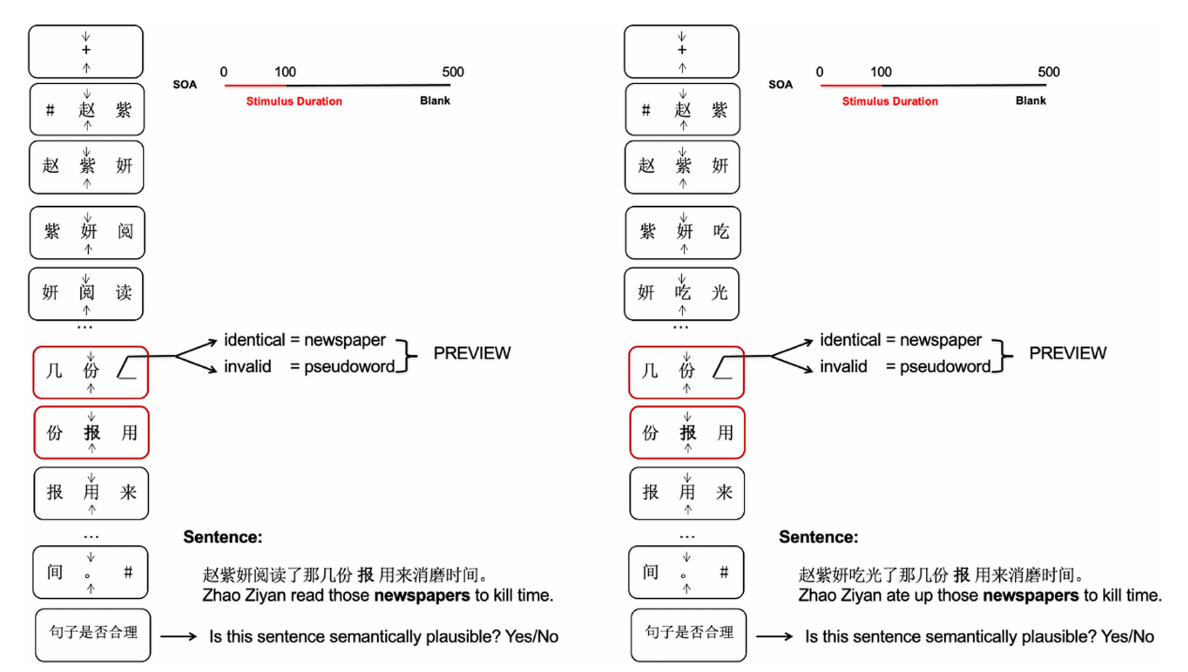
FIGURE 2 Trial scheme for the experiment. Sentences were presented character-by-character in the center of the screen, flanked by the preceding character to the left and the subsequent character to the right. Character triads were displayed for 100 ms each and separated by 400 ms blank intervals. The preview word position was presented either in its identity version (newspapers) or its invalid version (pseudoword) when the sentence was plausible (left side of the figure) and implausible (right side of the figure). Participants were asked to maintain their gaze on the central character (monitored with eye-tracking). They were also asked to judge the plausibility of the sentence with a button press at the end of the